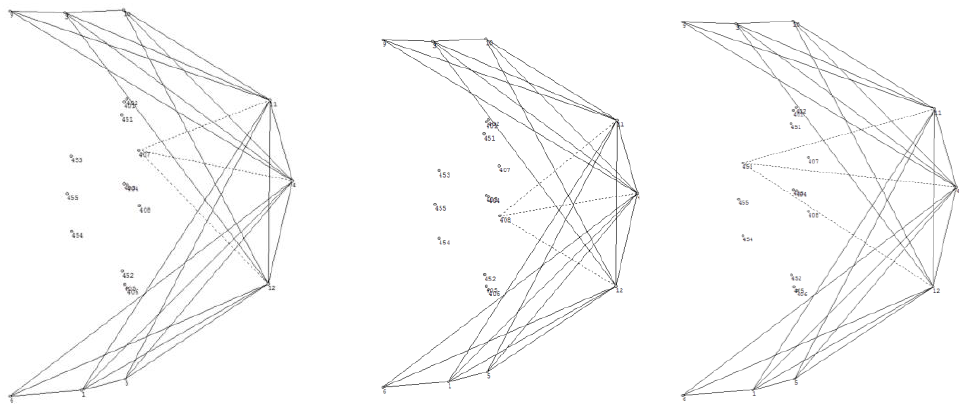
Figure 2. An example of photogrammetric control network measurement schema (multiple spatial angular-linear intersections for points 407, 408, 453).